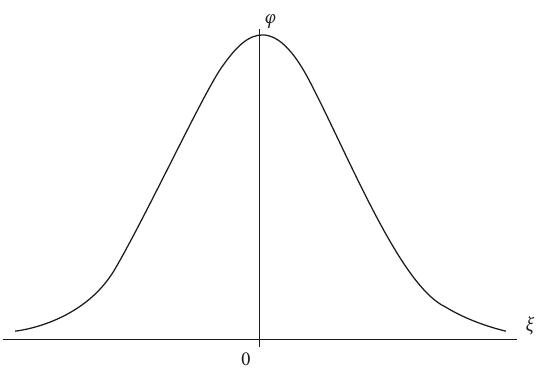
Figure 4: The solitary wave of equation (1) for c � ( 7/5 )